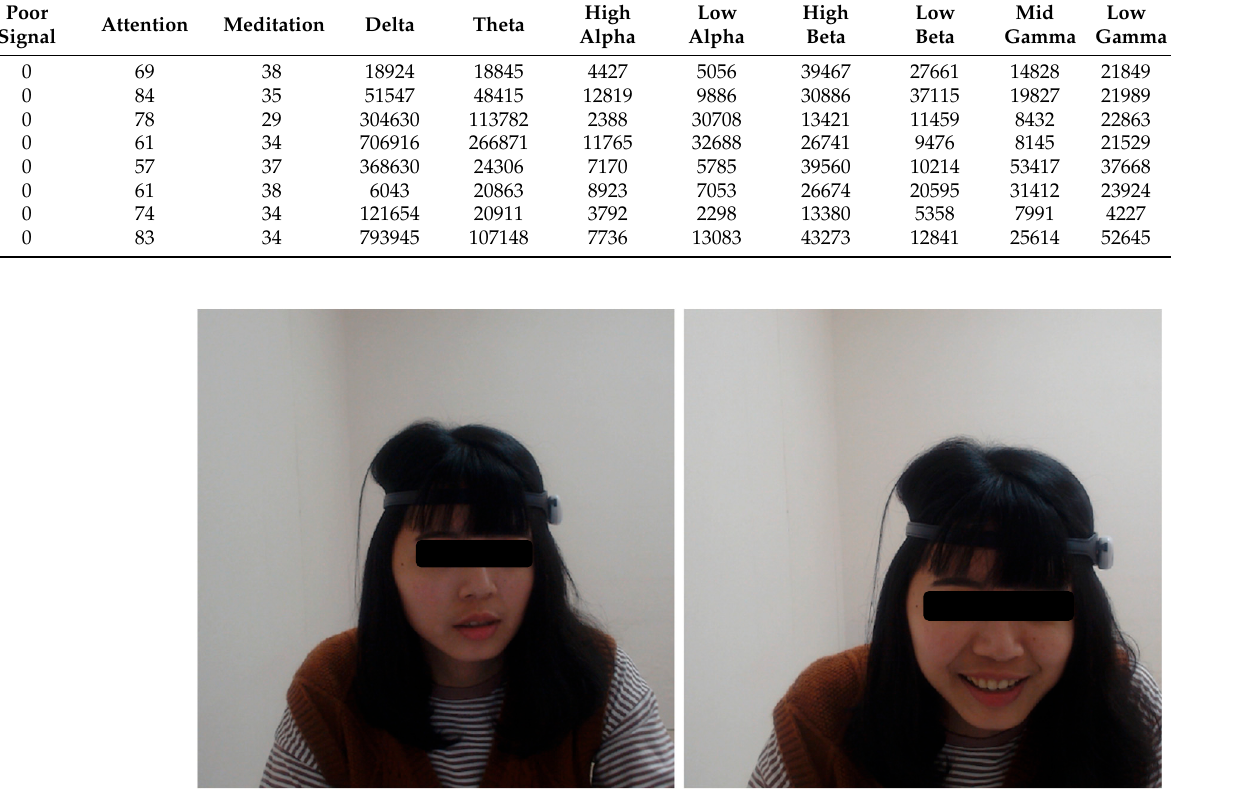
Figure 10. Facial expression of the participant was neutral at the beginning of the 2D game ( left ) and smiling during the 2D game ( right ).